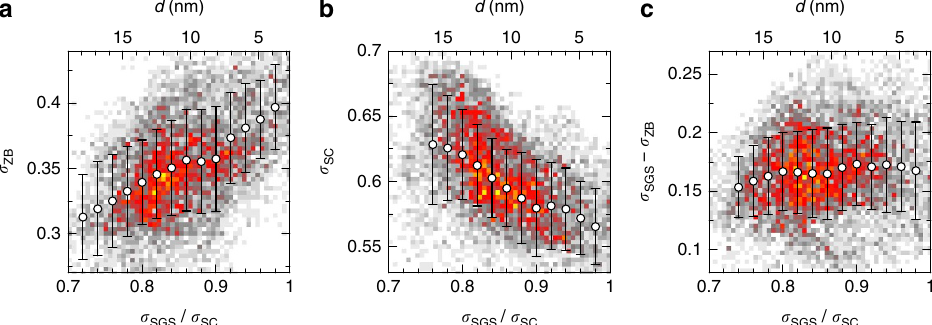
Figure 3 | Correlation of spectral features and distance from vortex-core centre. The conductance ratio s SGS / s SC evaluated along the white arrow of Fig. 2a provides a measure of the distance d from the vortex centre. We find a strong correlation between this distance and ( a ) the zero-bias conductance and ( b ) the conductance at D SC , but not with ( c ) the amplitude of the subgap states. The colour plots are histograms showing the frequency of each pair of values on the same area as in Fig. 2a (white–grey: low; red–yellow: high). The circles and error bars indicate the average and the standard deviation of the distributions at fixed values of the conductance